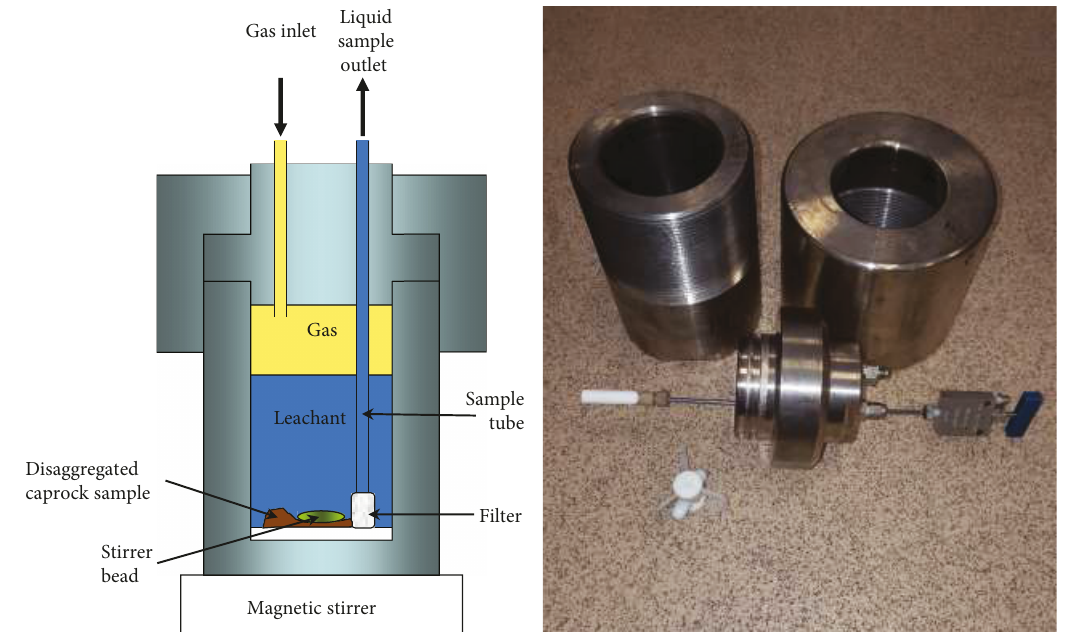
Figure 2: Schematic diagram and photograph of a titanium batch reactor.